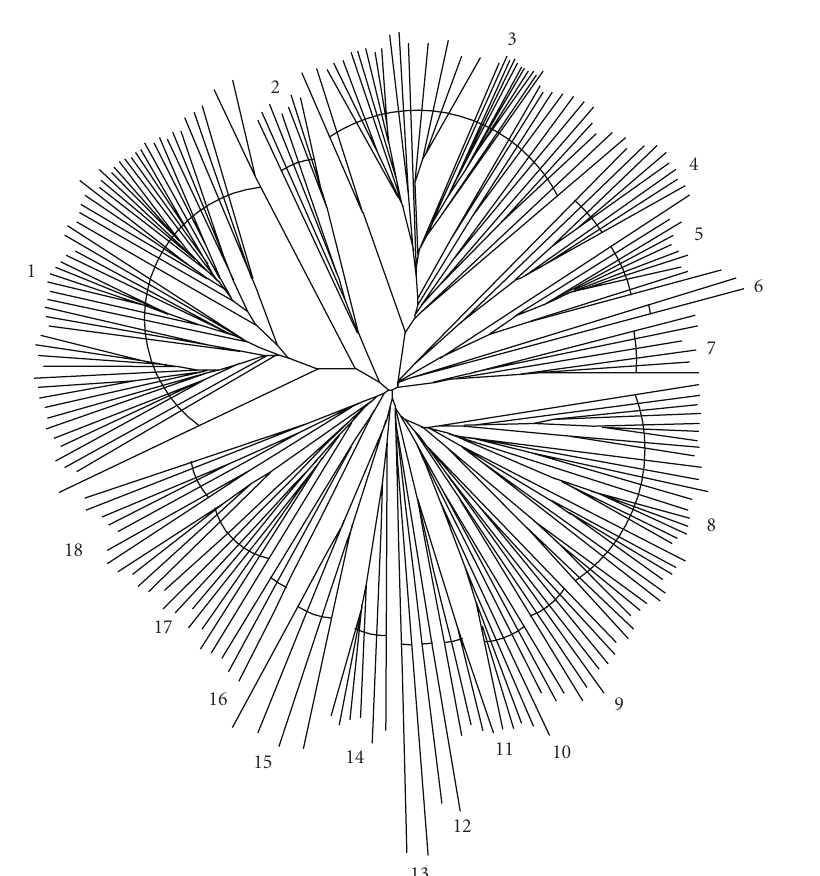
Figure 1: Phylogenetic tree of full length prokaryotic and eukaryotic ArsA homologues. The CLUSTAL X program [23] was used to create a multiple alignment of the protein sequences, while TreeView [24] generated the tree. The phylogenetic clusters are labeled 1–18 clockwise. Specific proteins can be found in Table 1, first according to cluster number and then according to position within the cluster. The dendrogram is shown in Figure